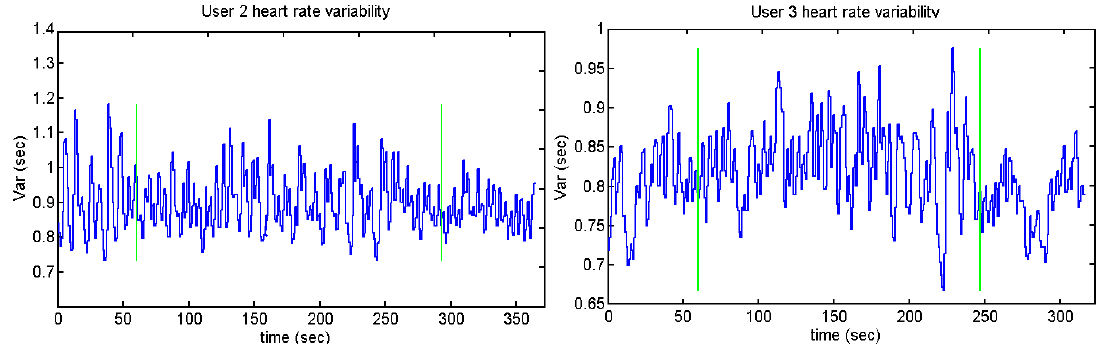
Figure 39. Heart rate variability of users 2 and 3 from Sounds Test.